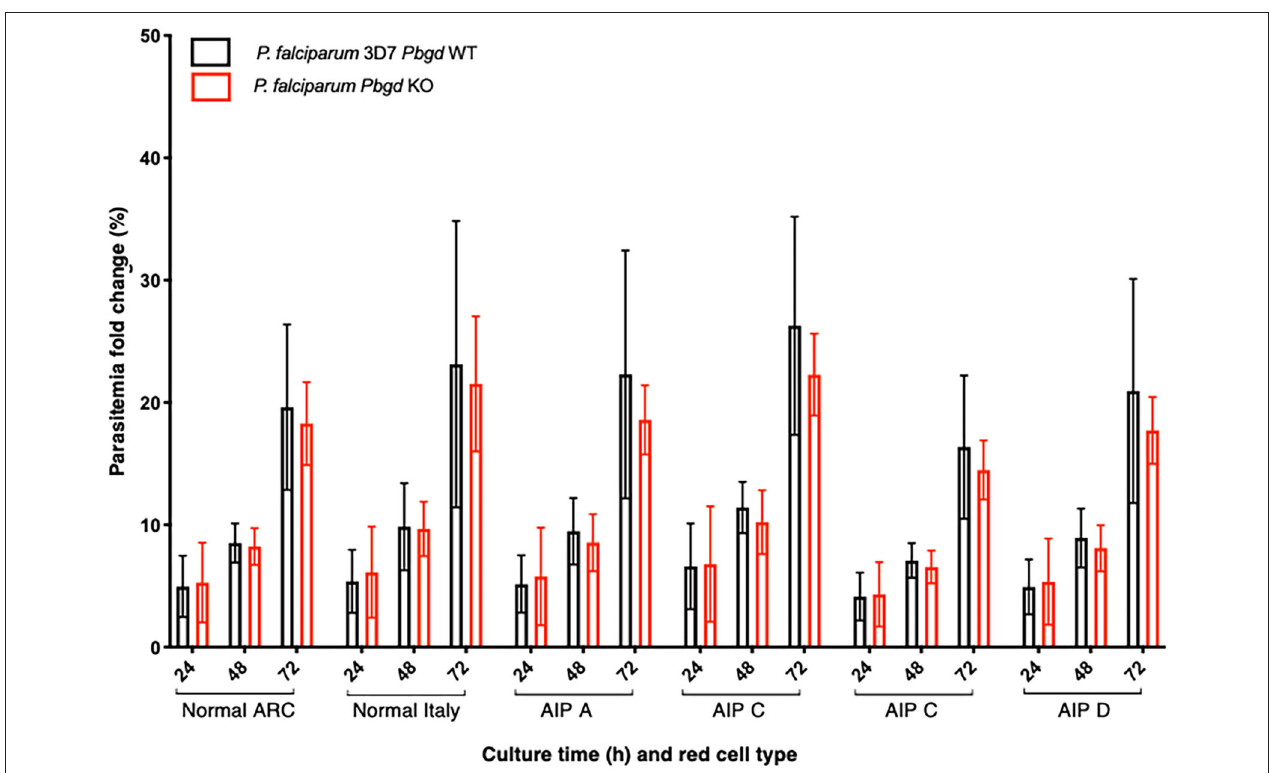
FIGURE 4 | Parasite growth analysis of wild-type and Pbgd -knockout P. falciparum in erythrocytes from normal and AIP individuals. Parasite growth following inoculation of wild-type ( Pbgd WT) or Pbgd -knockout ( Pbgd KO) P. falciparum into erythrocytes isolated from healthy individuals (Normal ARC and Normal Italy) and from four AIP individuals (A-D; see Table S4 for biochemical and PBGD activity characteristics). The parasites were cultured for up to 72h. Data represent the mean fold changes ( + /– SD) for two independent growth assay experiments, except for AIP B which was assayed once. There were no statistically significant differences comparing between the Normal and AIP samples, or between the two parasite strains using two-way ANOVA.